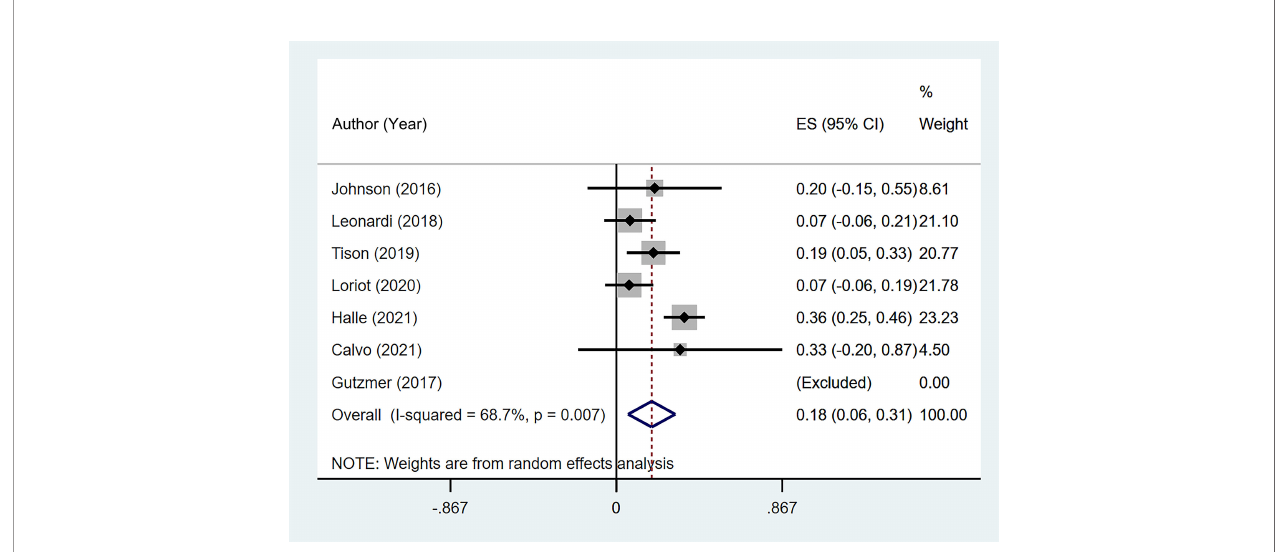
FIGURE 6 | The pooled incidence of immune checkpoint inhibitor (ICI) therapy discontinuation due to fl are/ de novo immune-related adverse event (irAE) in patients with cancer and preexisting